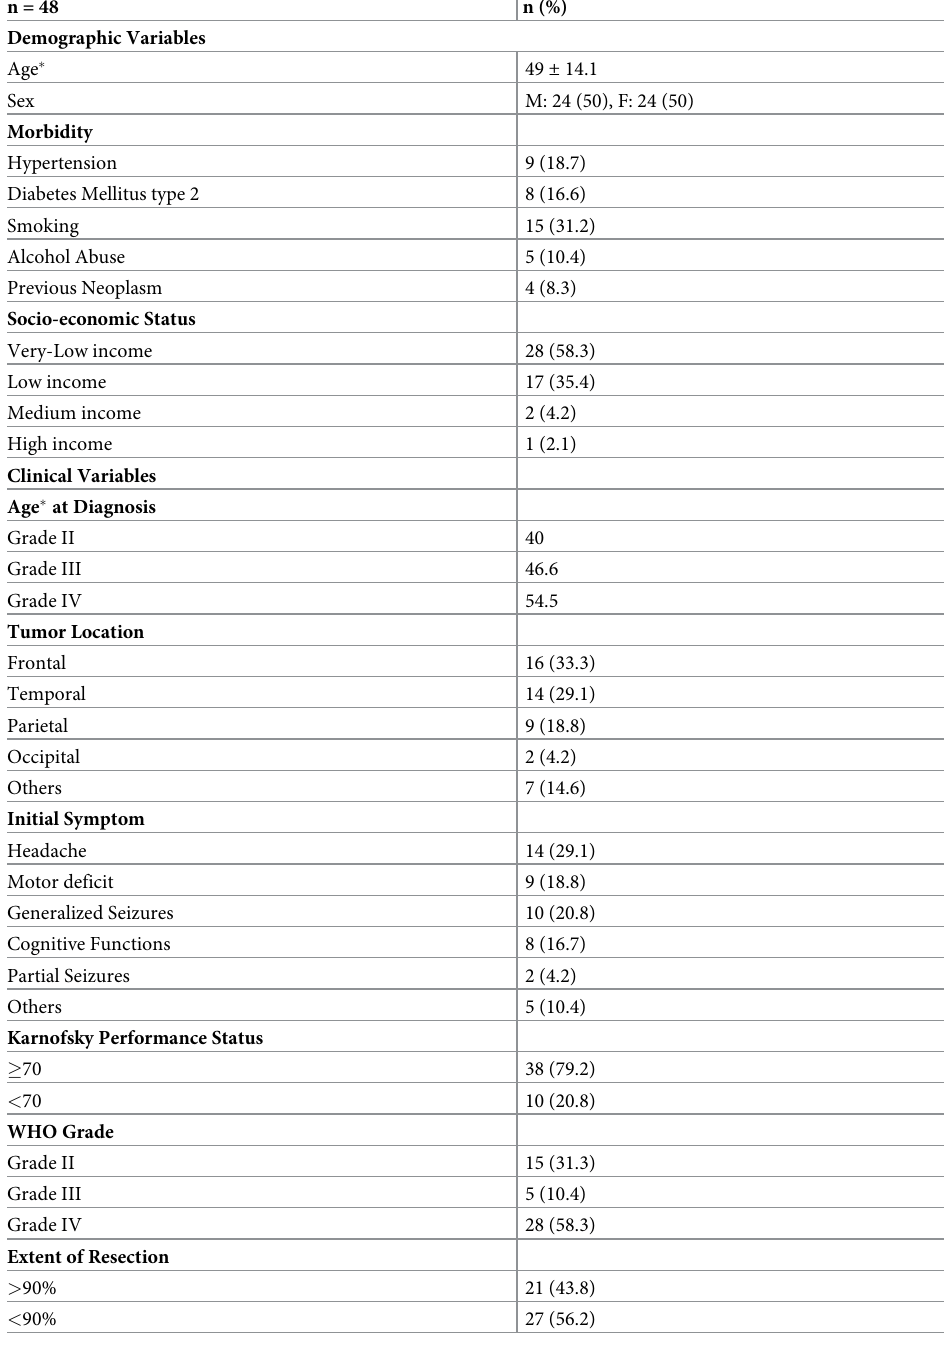
Table 1. Demographical and clinical